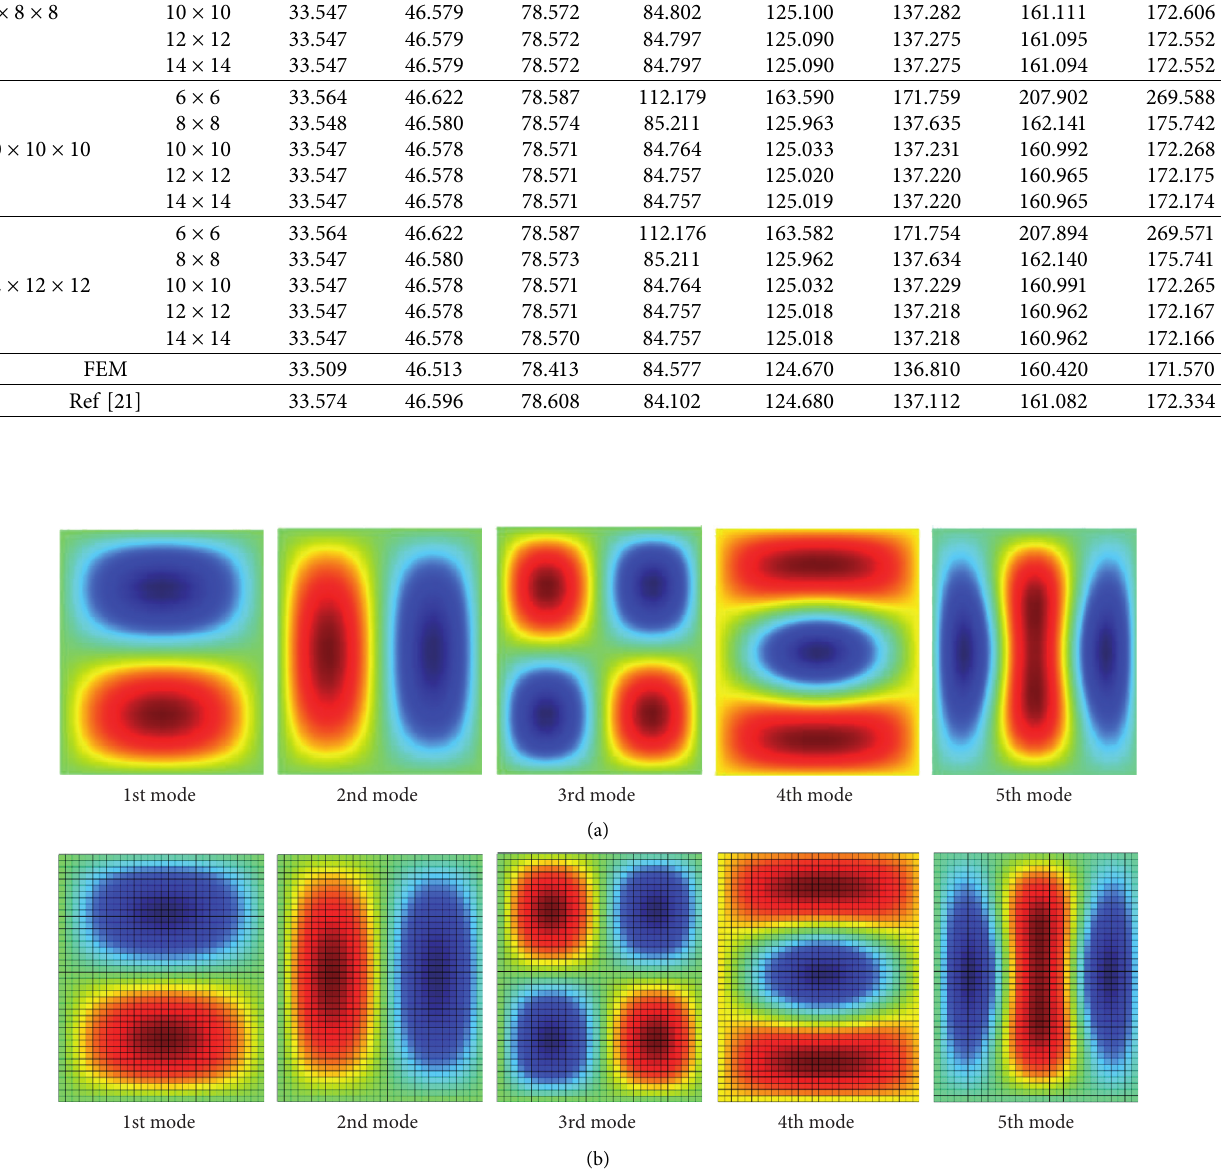
Figure 2: The first five structural modes of the strongly coupled panel-cavity system. (a) FEM. (b) Present